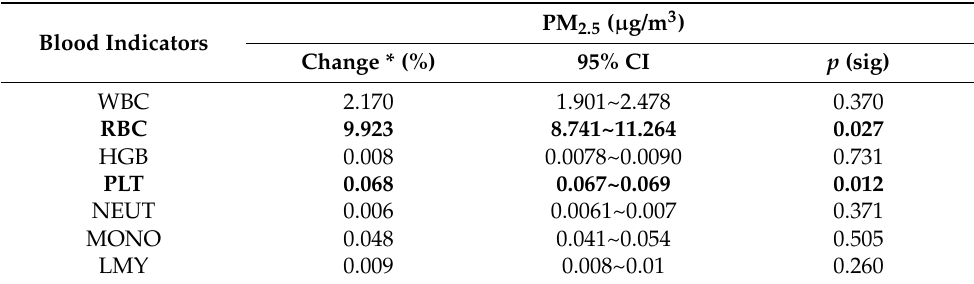
Table 5. Correlation between PM 2.5 concentration and blood routine parameters during pol- luted weather.